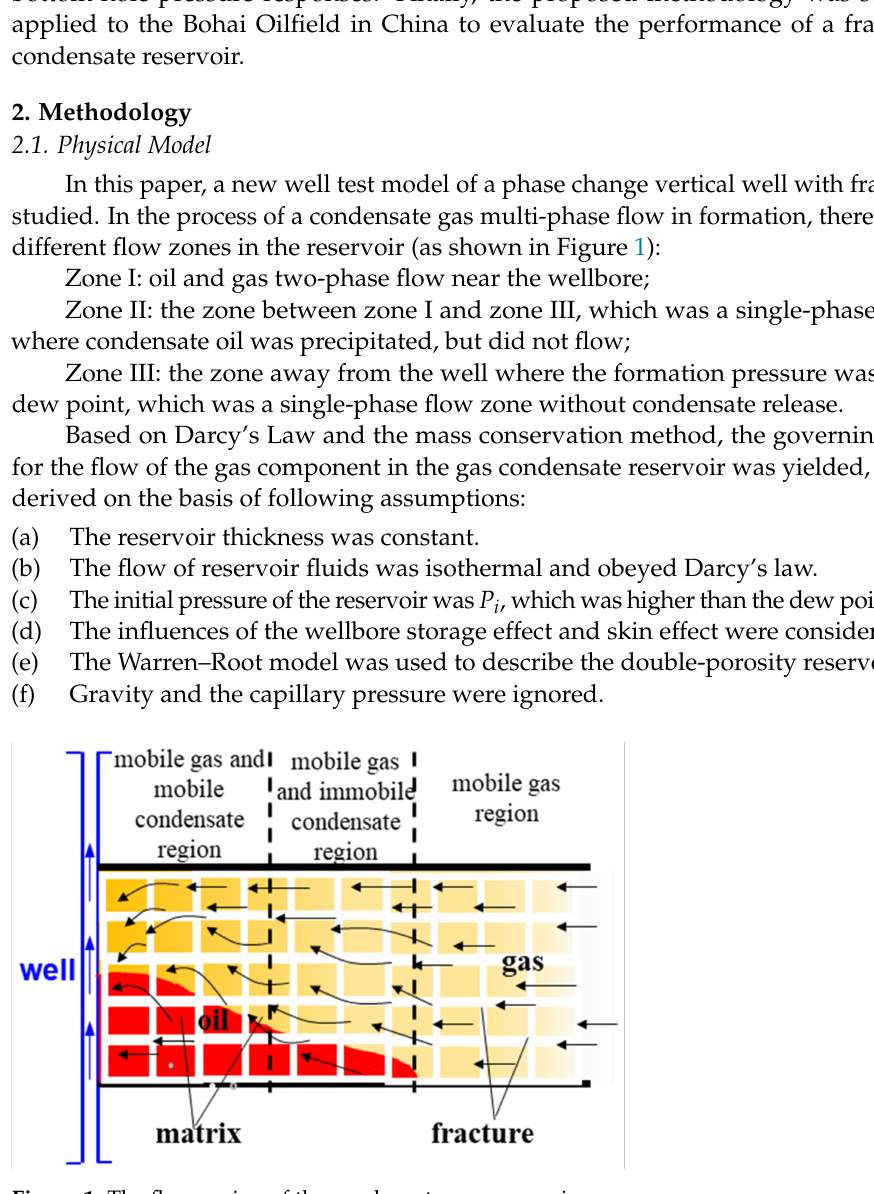
Figure 1. The flow region of the condensate gas